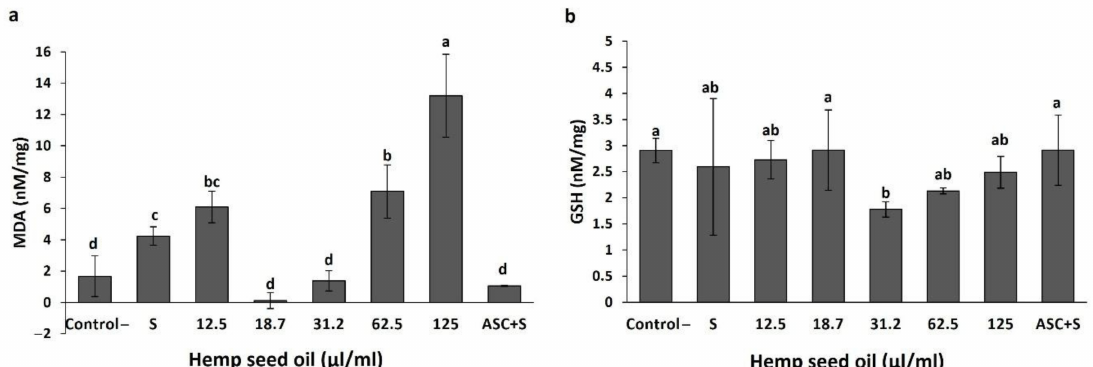
Figure 3. Effects of hemp seed oil on malondialdehyde (MDA) ( a ) and glutathione (GSH) ( b ) contents in D. melanogaster larvae under chronic H 2 O 2 -induced oxidative stress. The hemp seed oil was applied to the H 2 O 2 -contained feeding medium at six concentrations (0 (S), 12.5, 18.7, 31.2, 62.5 and 125 µ L/mL), compared to an unstressed negative control (control-), and a positive control of ascorbic acid (ASC + S). All values are expressed as means ± SD. Different letters above the means represent significant differences between treatments ( p < 0 05; LSD